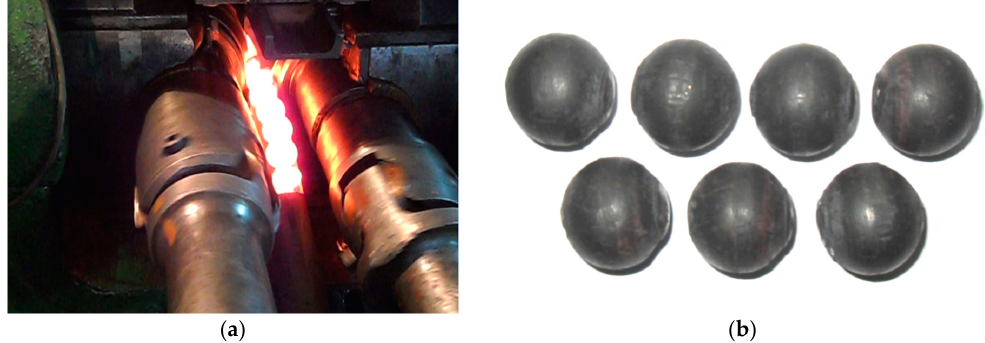
Figure 3. Balls manufactured by helical rolling in a tubular guide. ( a ) rolling process; ( b ) rolled balls.